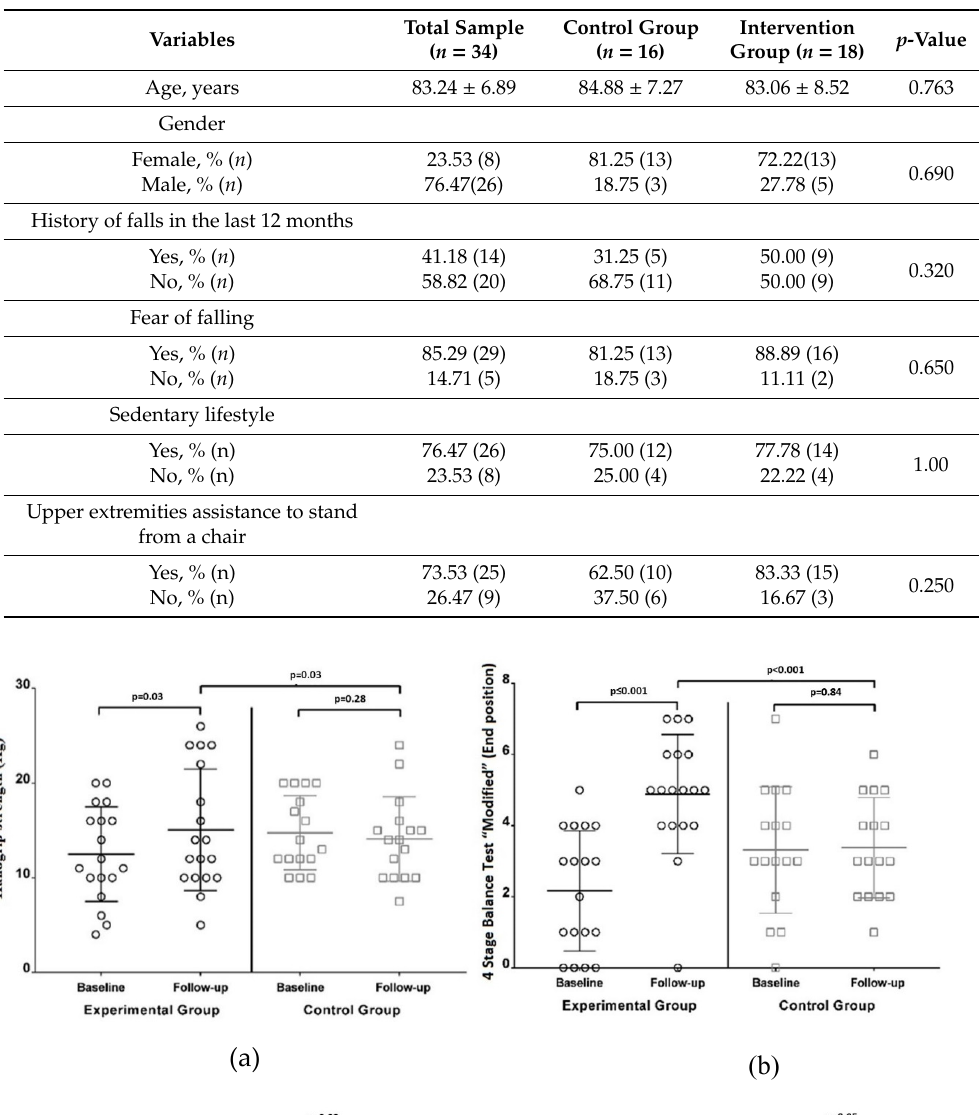
Table 1. Demographic and clinical characterization of the total sample, control group, and intervention group at